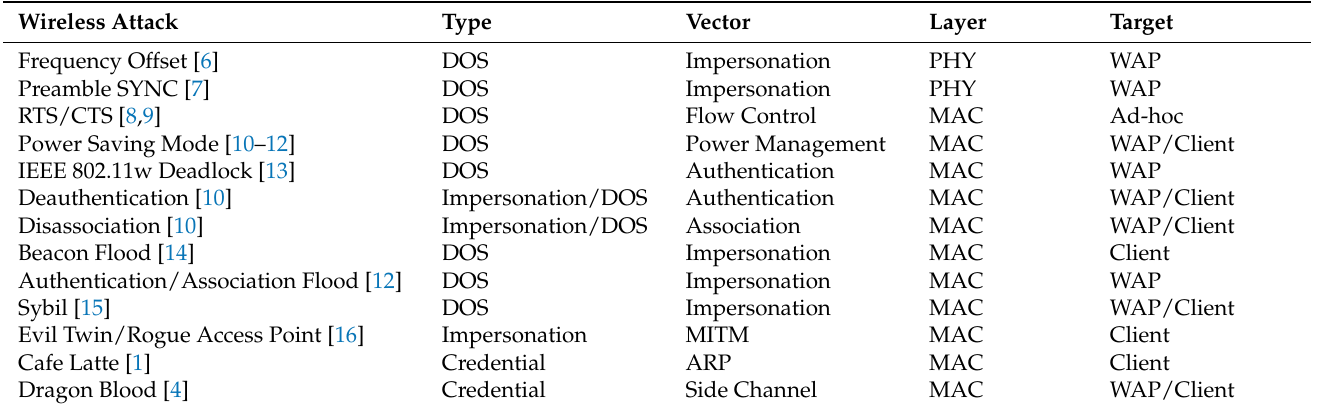
Table 1. Examples of IEEE 802.11